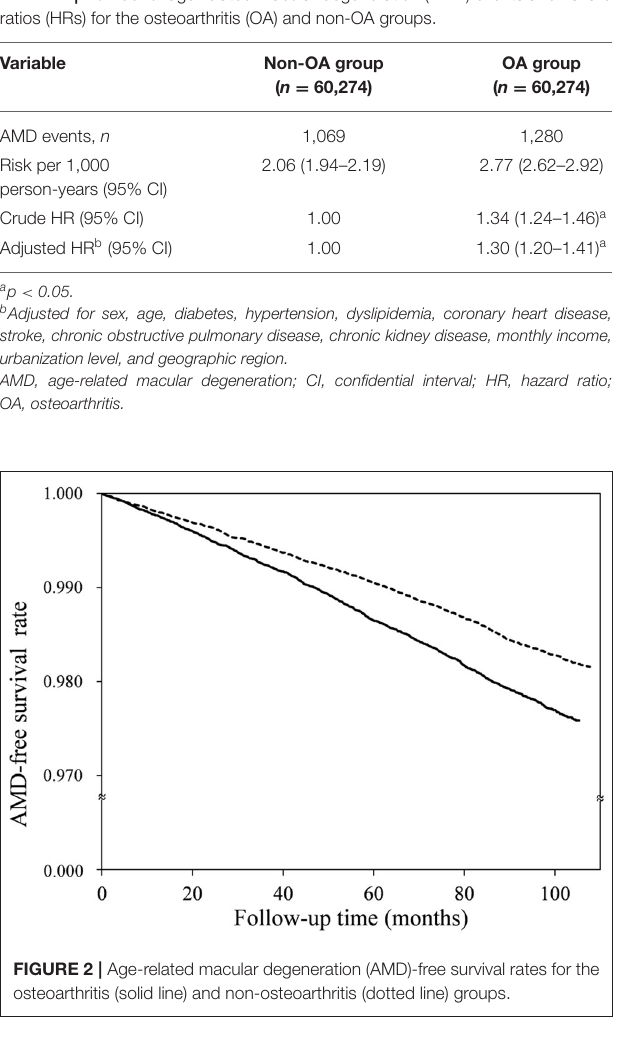
over 518,354.5 person-years: an incidence rate of 2.06/1,000 person-years (95% CI, 1.94–2.19). Thus, as compared with the non-OA group, the adjusted HR of AMD for the OA group was 1.30 (95% CI, 1.20–1.41, p < 0.0001). In addition, the AMD-free survival rate of the OA group was lower than that of the non-OA group ( Figure 2 , p < 0.0001). Table 3 present the results of subgroup analysis of AMD risk, stratified by sex and age, respectively. In the former, the adjusted HRs of AMD for the OA group in the women’s and men’s strata were 1.29 and 1.31, respectively. In other words, women and men